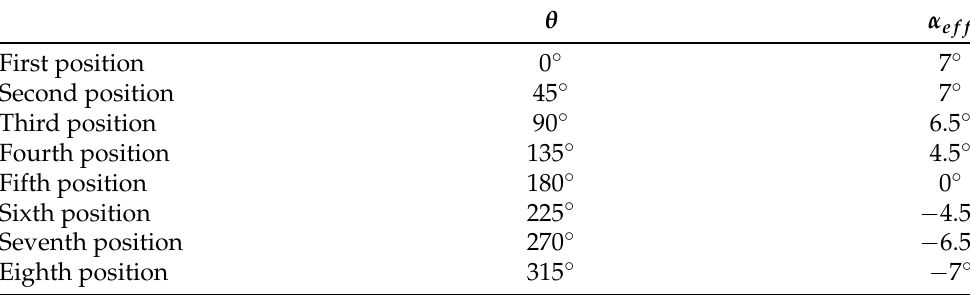
Table 3. Values of α ef f at the eight azimuthal positions.